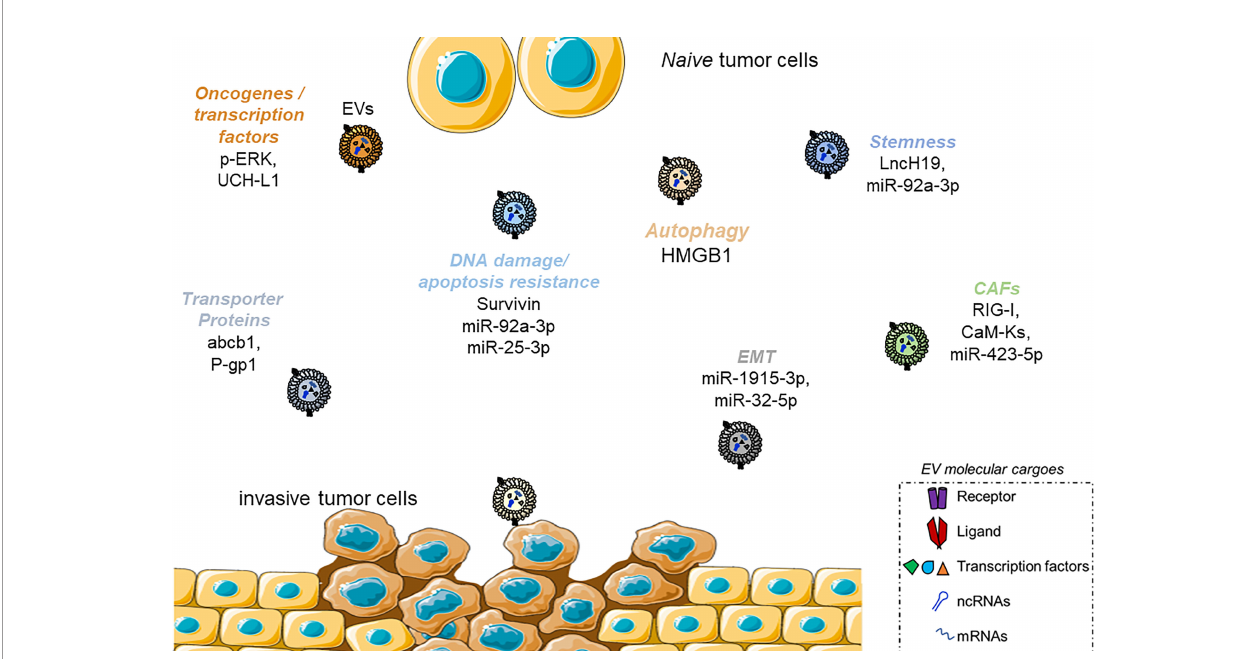
FIGURE 4 | Scheme summarizing the mechanism of drug resistance activated by EVs. Examples of molecular players for each category, as described in Figure 2 , are reported. Only molecules shuttled by EVs are